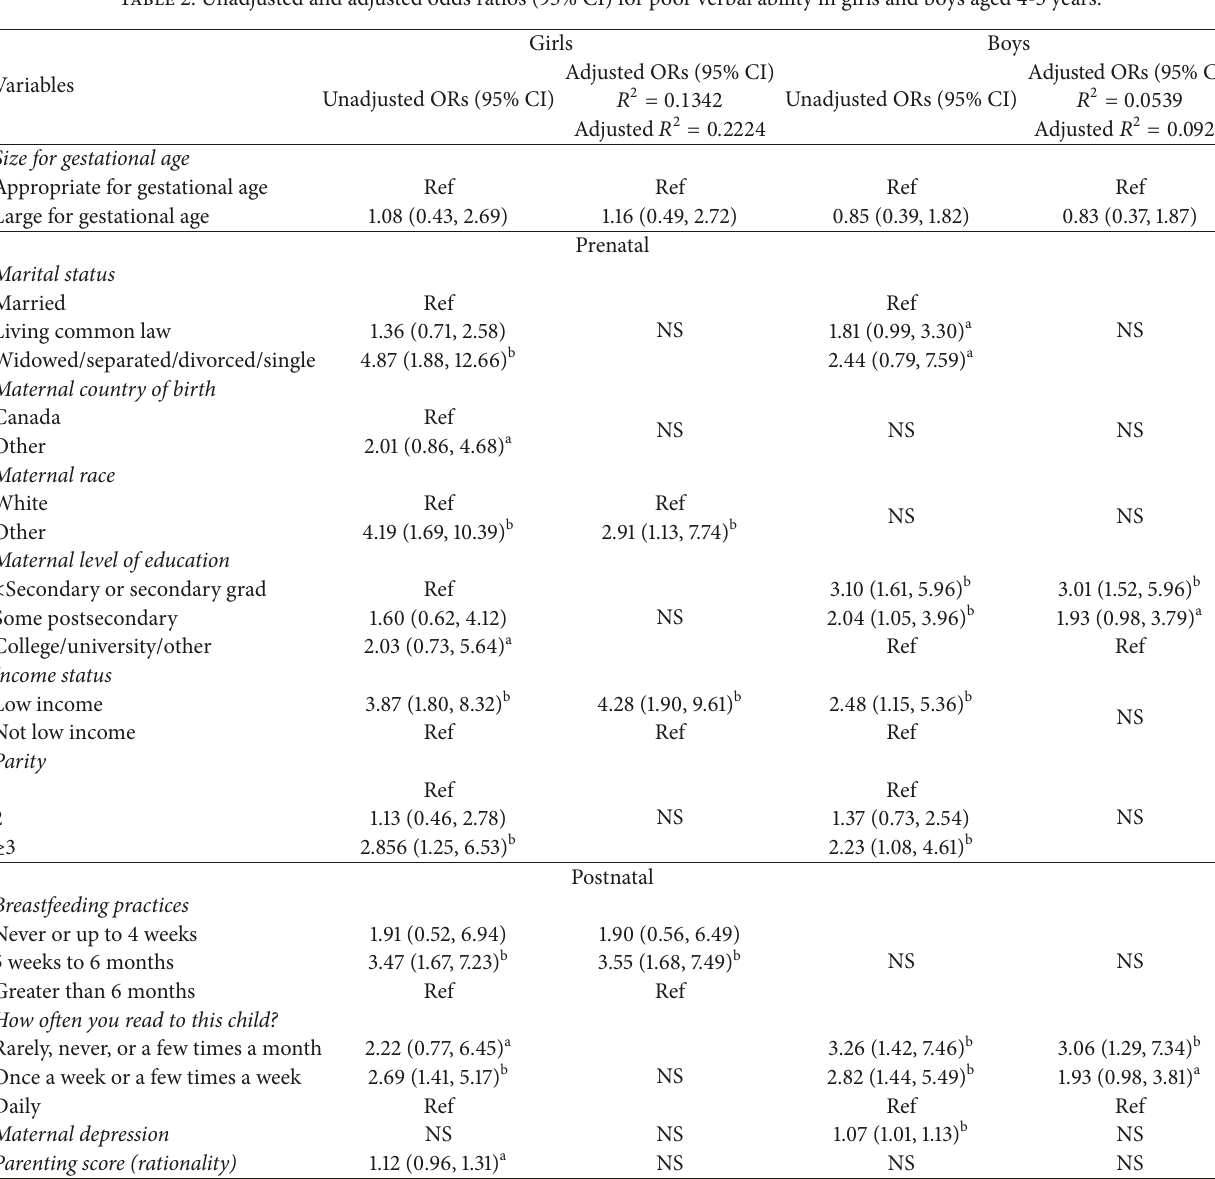
Table 2: Unadjusted and adjusted odds ratios (95% CI) for poor verbal ability in girls and boys aged 4-5